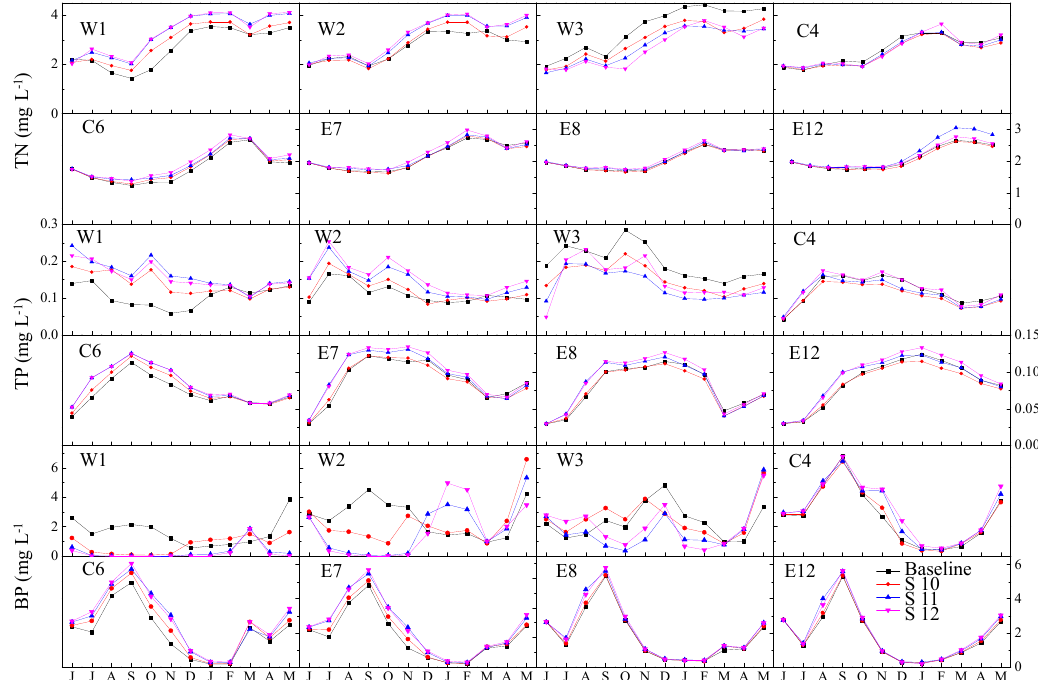
Figure 10. The concentration of TN, TP, and BP in Lake Yangchenghu after entrances adjustment of tributaries.